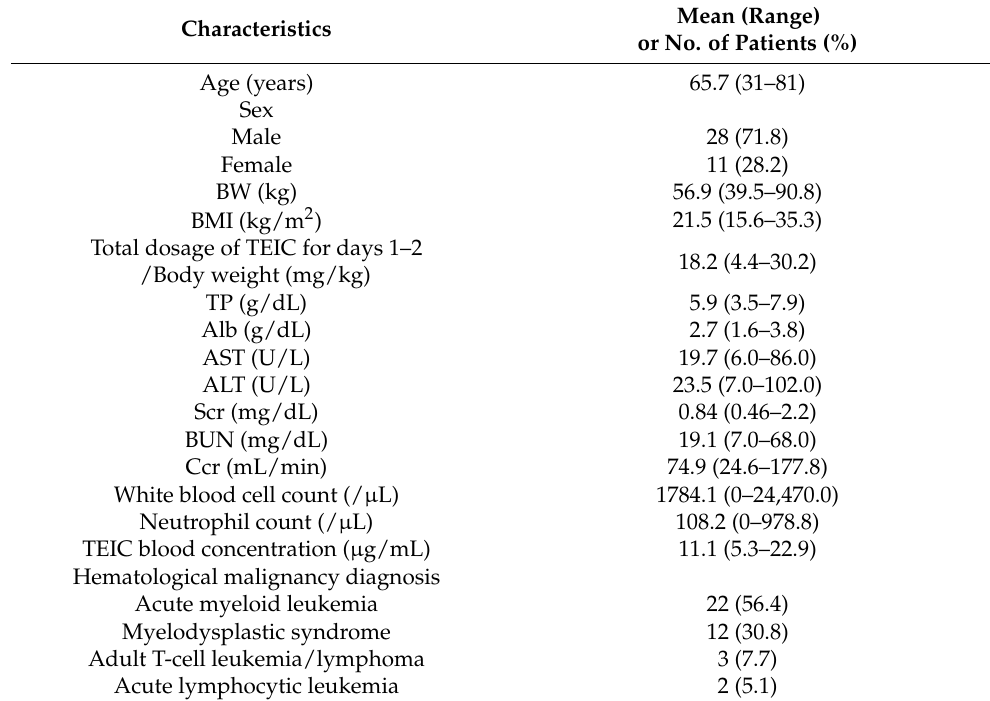
Table 2. Baseline characteristics of the